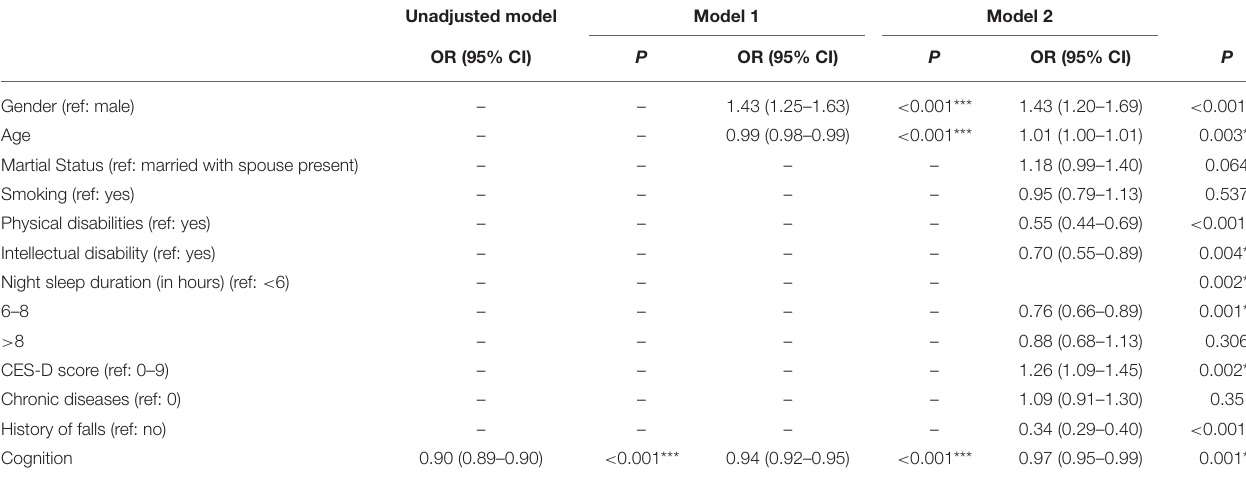
TABLE 4 | Logistic regression analysis of cognitive function and subsequent falls ( n =